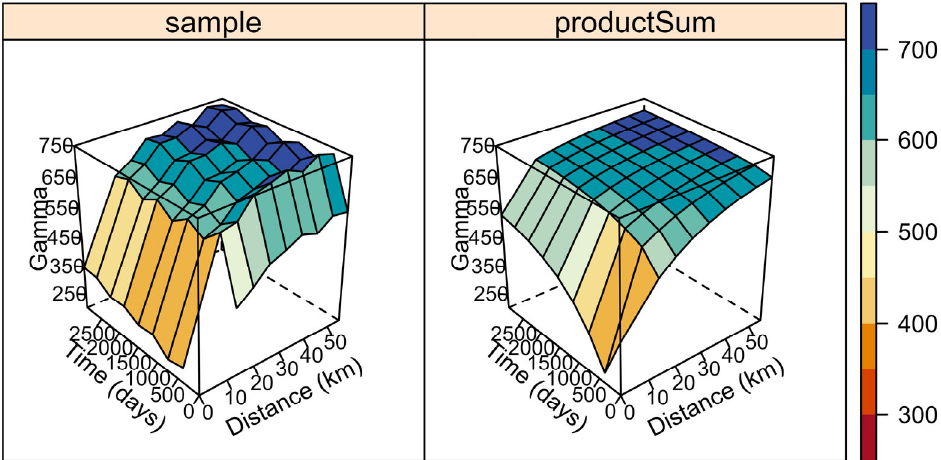
Figure 5. Experimental variograms ( left side ) and the theoretical generalized product-sum ( right side ) for the number of days without rain in the year after removing the tendency.